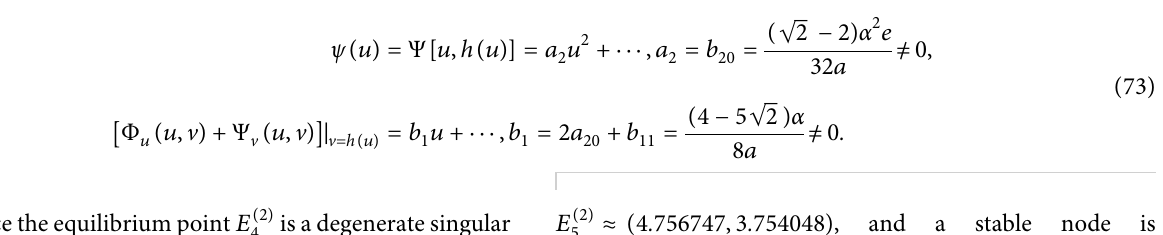
Figure 5: (a) A cusp E ( 2 ) E ( 1 ) in the case 5